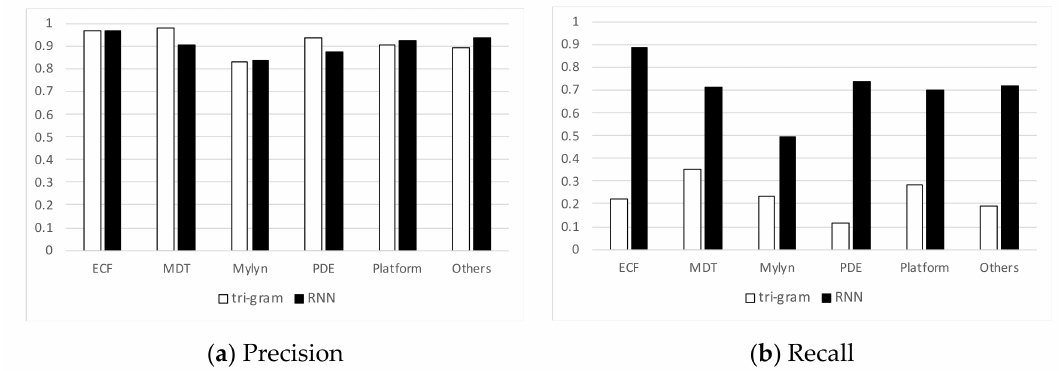
Figure 1. The preliminary experimental results with N-Gram and RNN, Reprinted with permission from ref. [5], Copyright 2018 Korea Information Processing